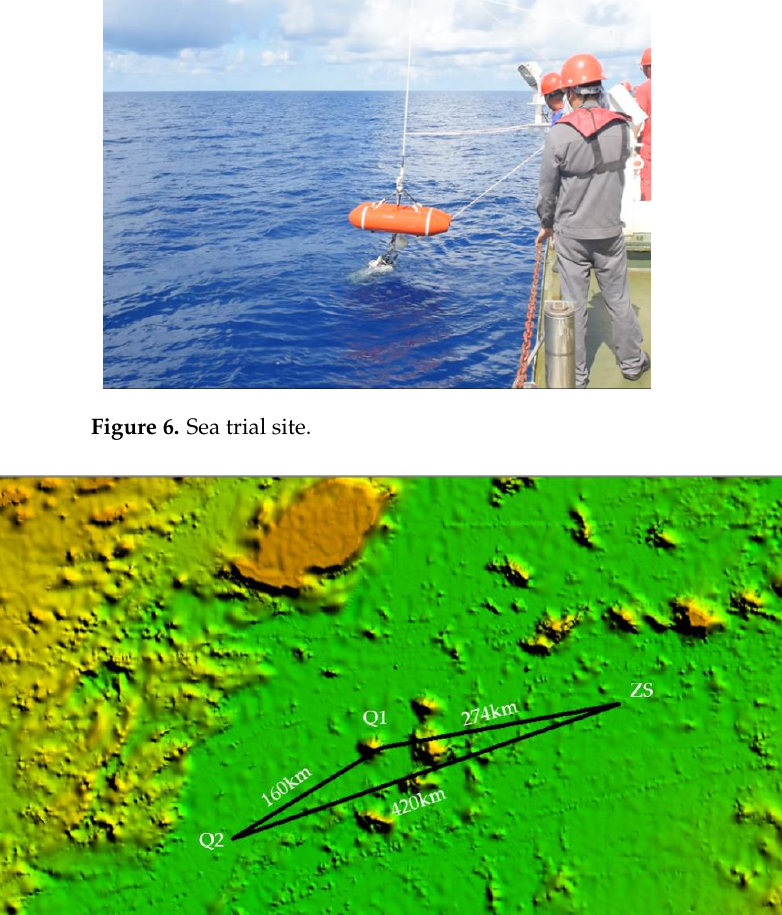
Figure 7. Experimental area.